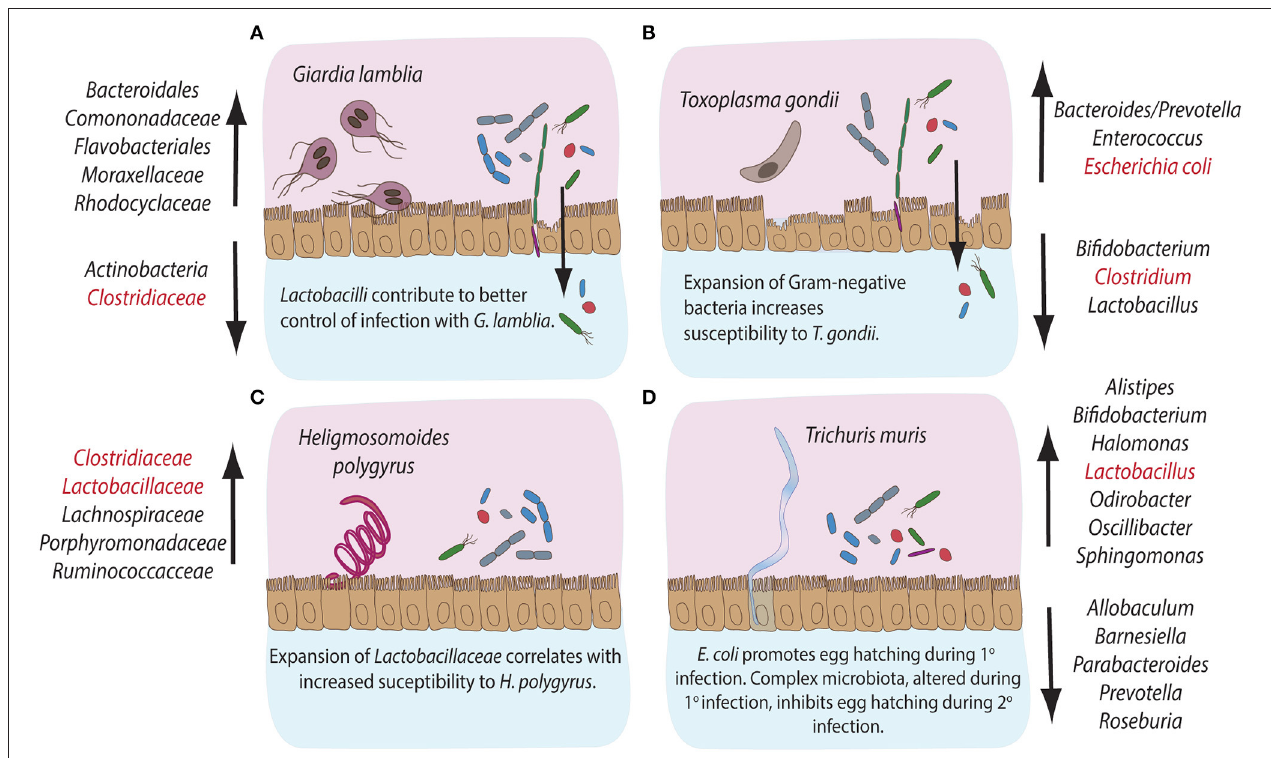
FIGURE 2 | Compositional alterations and functional significances of commensal bacterial groups during intestinal parasite infections in mice. The gastrointestinal tract of mice is home to diverse communities of commensal bacterial species. Infections with intestinal pathogens are known to lead to notable alterations in the commensal microbiota composition of the host. (A) Infection with the extracellular protozoan parasite Giardia lamblia leads to a significant expansion of bacterial groups like Bacteroidales, Comononadaceae, Flavobacteriales, Moraxellaceae and Rhodocyclaceae , while Actinobacteria and Clostridiaceae display reduced abundances. On the other hand, Lactobacilli are known to contribute to an overall better control of Giardia infection. (B) The intracellular protozoan parasite Toxoplasma gondii leads to expansion in Bacteroides/Prevotella, Enterococcus and Escherichia coli , while the abundance of Bifidobacteria, Clostridiales , and Lactobacilli decreases during infection. An overall expansion of Gram-negative bacteria has been shown to contribute to immunopathology during murine infection with T. gondii . (C) Infection with the small intestinal parasitic nematode Heligmosomoides polygyru s leads to a marked expansion of commensal Clostridiaceae, Lachnospiraceae, Porphyromonadaceae , and Ruminococcacce and Lactobacilli , the latter known to correlate with increased susceptibility to infection with H. polygyrus . (D) Infection with the large intestinal nematode Trichuris muris leads to the expansion of Alistipes, Bifidobacteria, Halomonas, Lactobacilli , Odirobacter, Oscillibacter , and Sphingomonas , while Allobaculum, Barnesiella , Parabacteroides, Prevotella , and Roseburia abundances decrease. Notably, commensal E. coli is known to promote egg hatching during primary infection, while complex microbiota alterations occurring during primary infection appear to inhibit egg hatching during secondary infection with T. muris . The bacterial groups highlighted in red have been demonstrated to take part in induction, maintenance or suppression of host immune responses during the corresponding parasitic